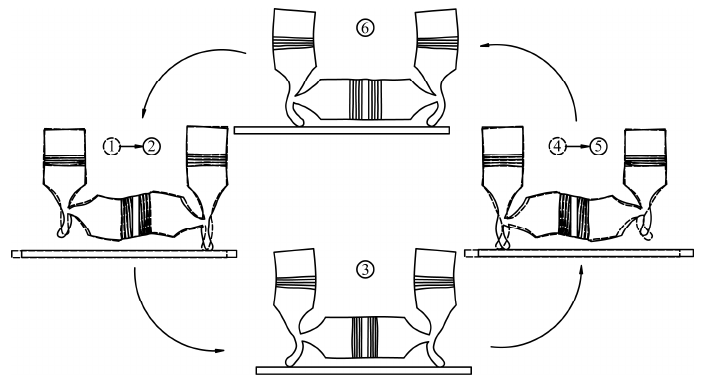
Figure 4. The working principle of the proposed PUM.